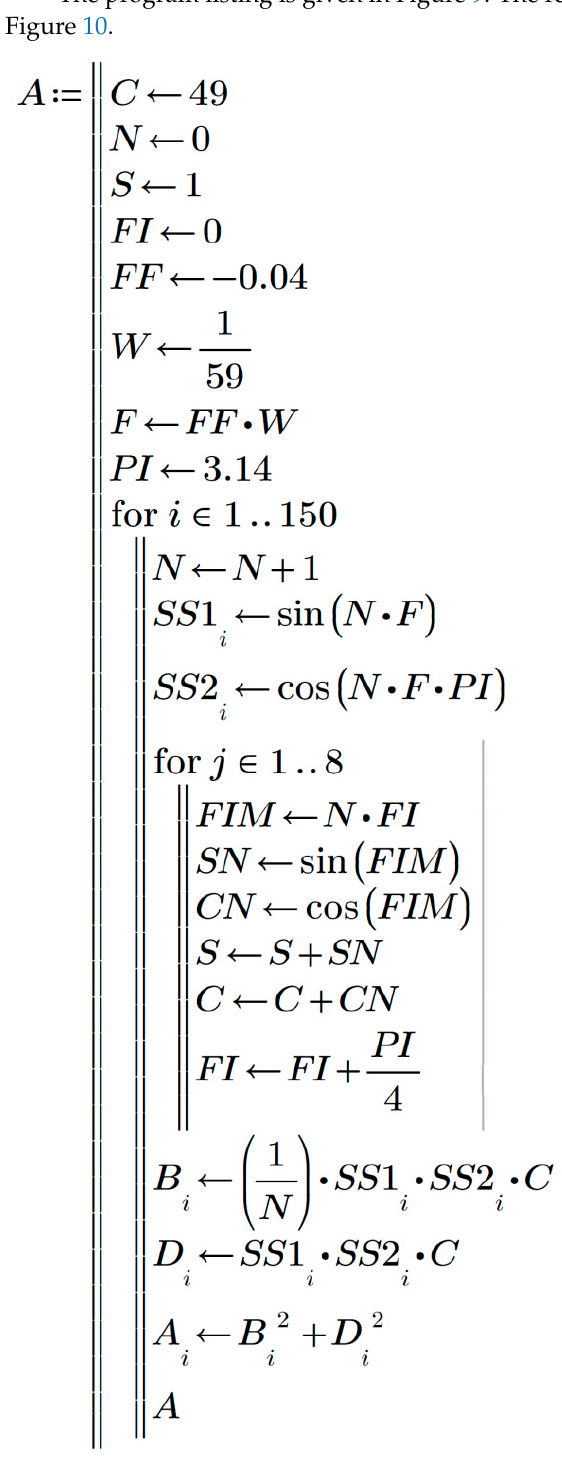
Figure 9. The program listing.